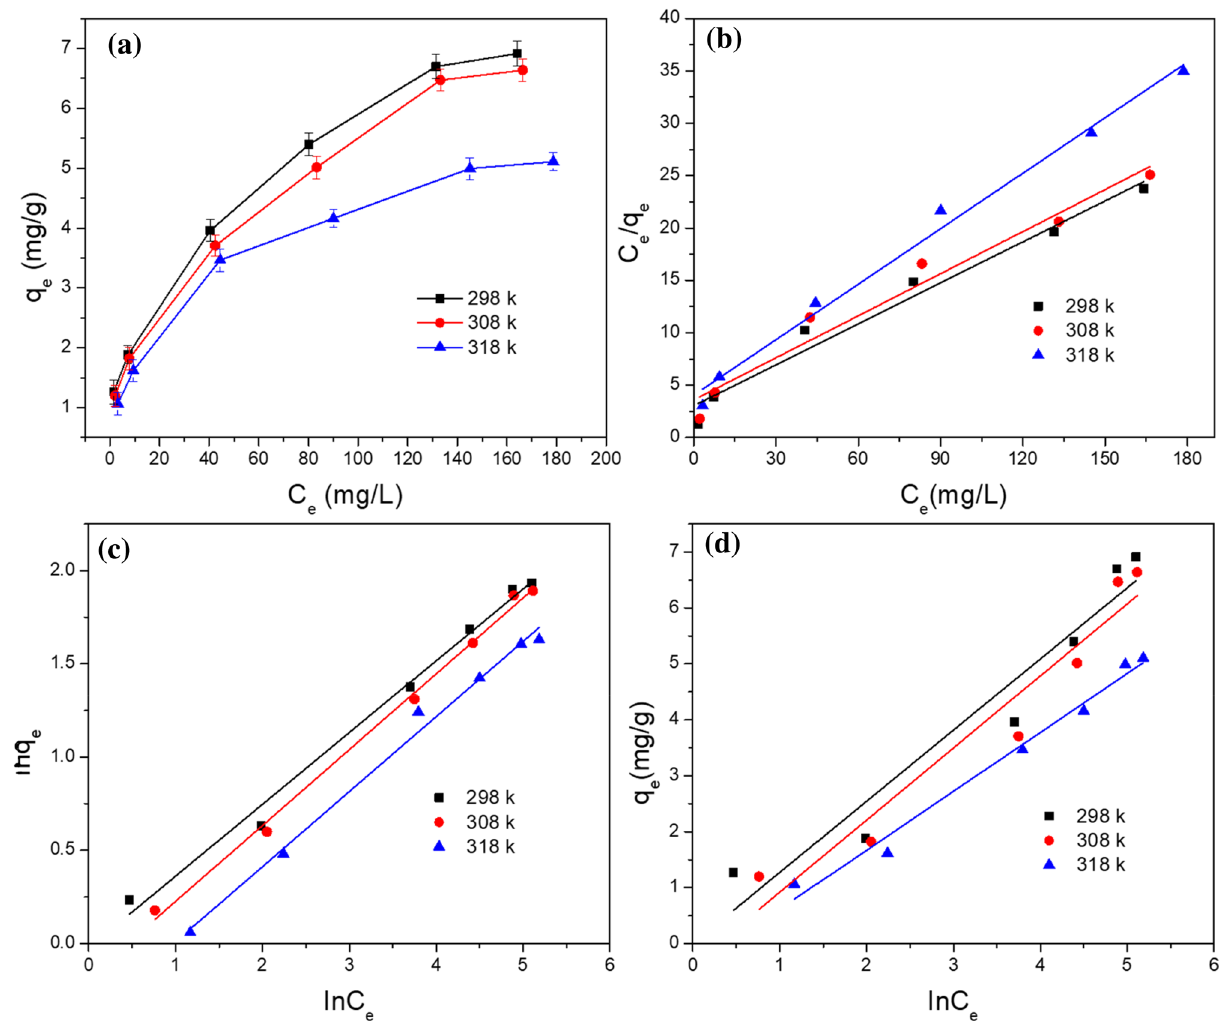
Figure 6. ( a ) Effect of temperature on the removal of Sb(III) by GAD. ( b ) Langmuir isotherm fitting. ( c ) Freundlich isotherm fitting. ( d ) Temkin isotherm fitting (pH = 6; dosage = 400 mg/50 mL dry weight; Sb(III) concentration = 10–220 mg/L; temperature = 298, 308, 318 k; rotation speed = 150 rad/min; contact time = 240 min).